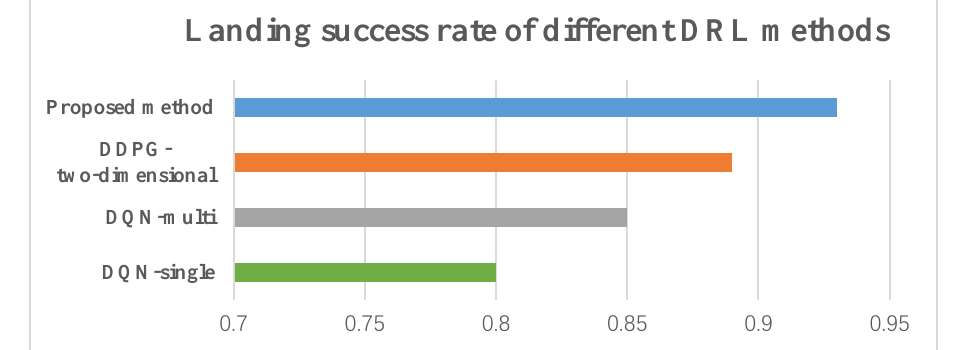
Figure 10. The results of landing simulation with different deep reinforcement learning (DRL) methods. The moving platform performed a uniform straight-line motion at a speed of 3 m/s.